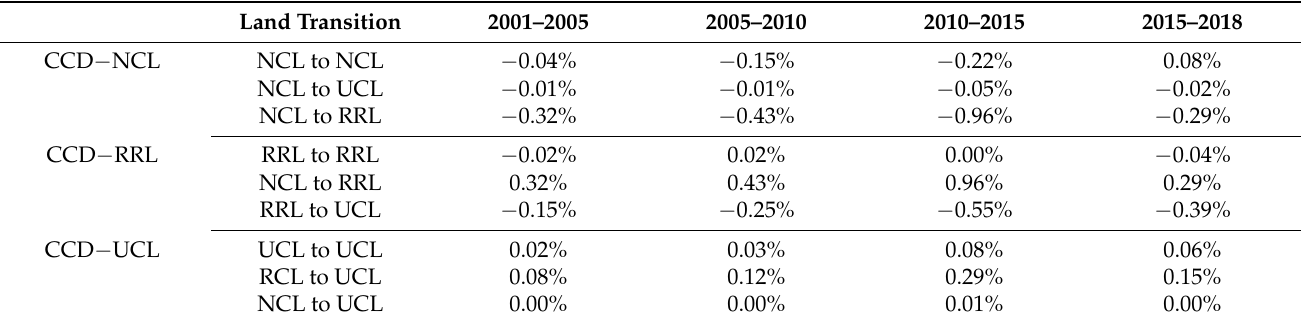
Table 2. The change in CCD-NCL, CCD-RRL, and CCD-UCL from 2001 to 2018 in China. Land